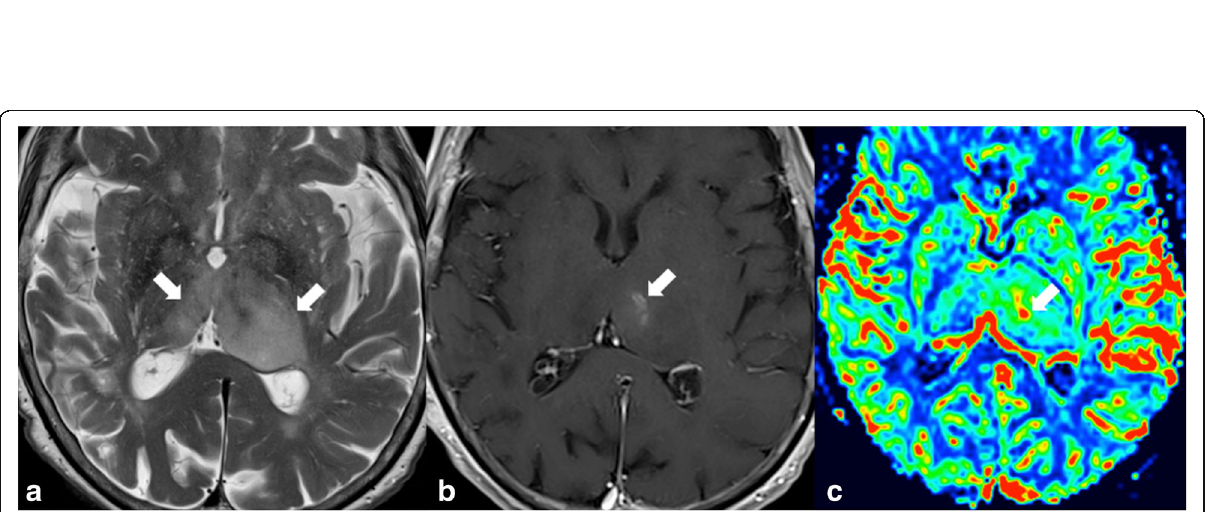
Fig. 2 T2WI hyperintense lesions in the thalami (arrows in a ), with mass effect on the third and left lateral ventricles, showing faint enhancement on the left thalamus (arrow in b ). Note that the hypervascularisation on the CBV map sequence (arrow in c ), reflecting neoangiogenesis, perfectly matches the enhancing component of the lesion, which corresponded to a biopsy-proven high-grade